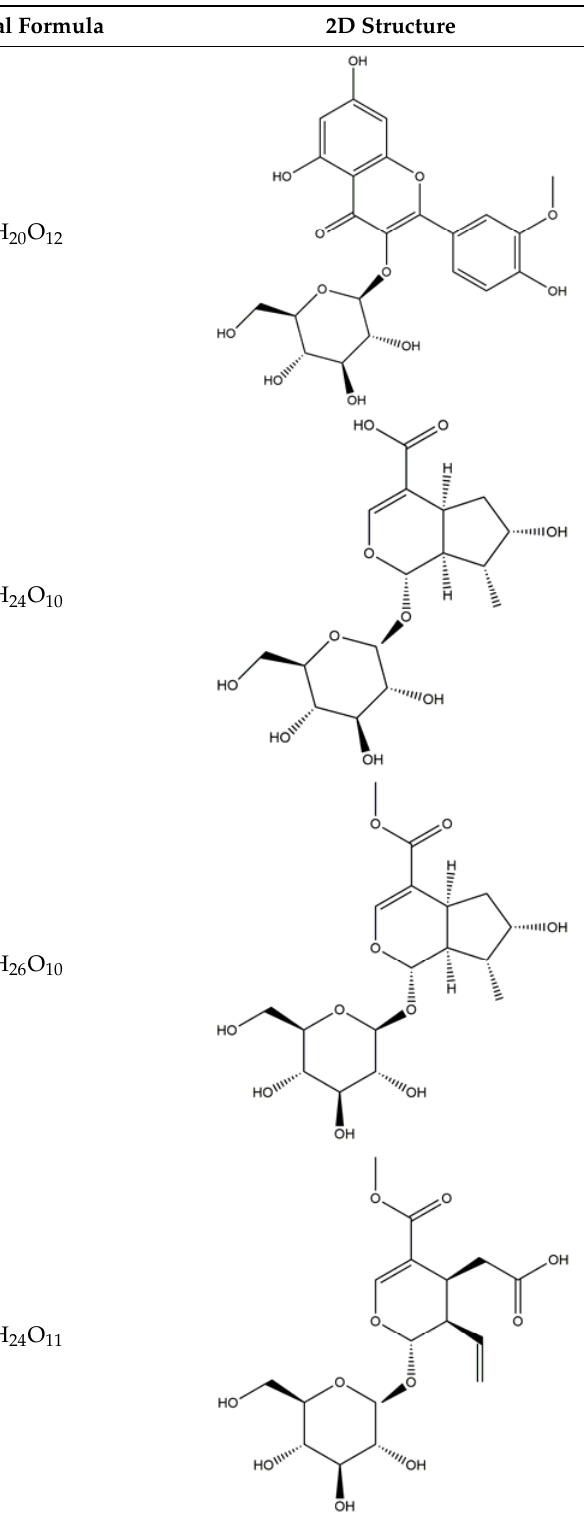
5 of 16 Table 1. Main active ingredients from LJF. NO. Name